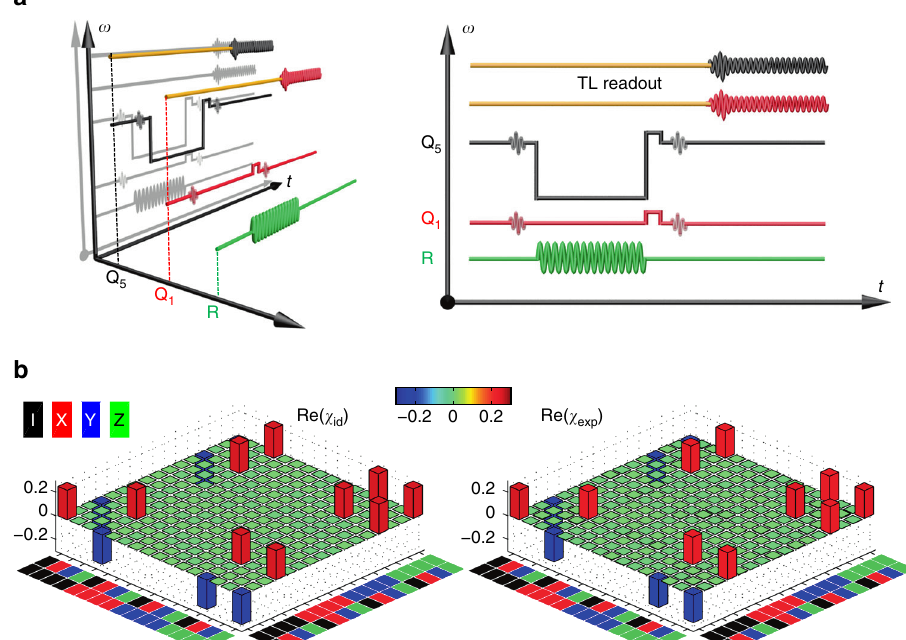
ffiffiffiffiffiffiffi p 7 : 0 MHz and detuning δ /2 π = 4 MHz. a Pulse sequences ffiffiffi ffiffiffi p p 2 , 0 j i þ 1 j ið Þ = 2 , 1 j ig }; the second sinusoid with a